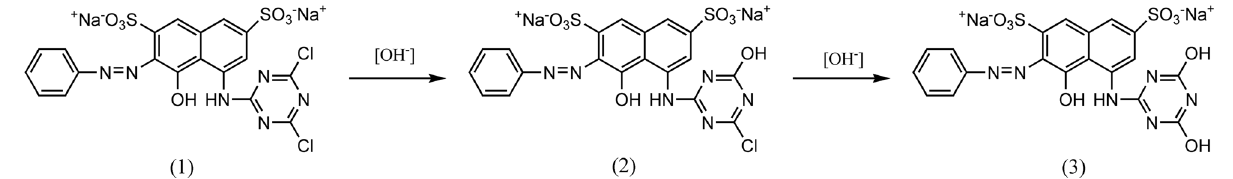
Figure 3. The hydrolysis process of Red 2 in alkaline solution.